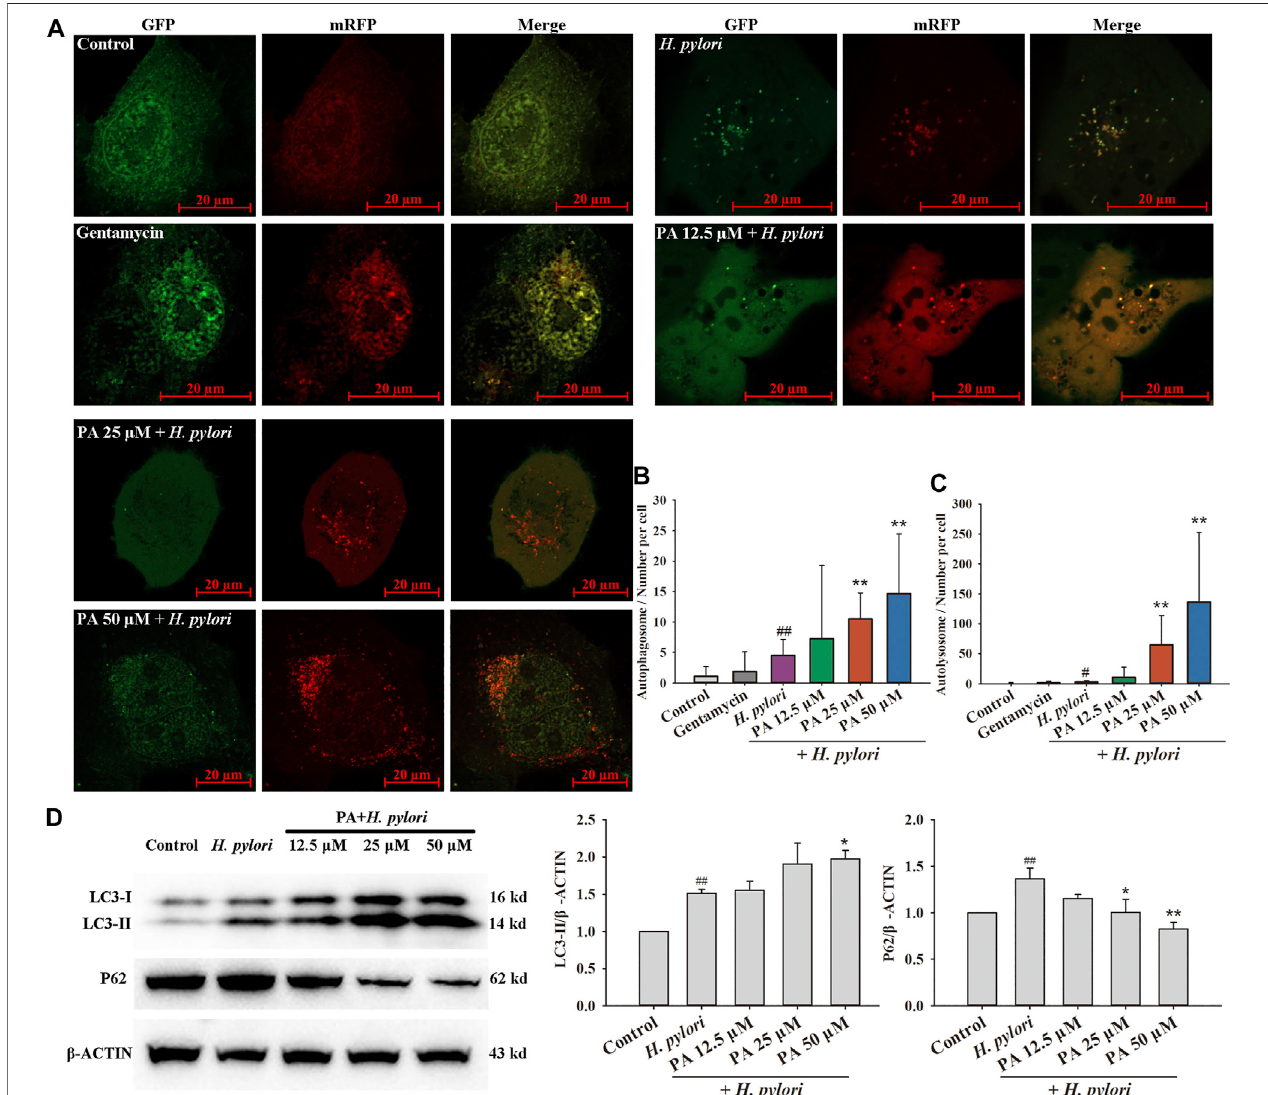
FIGURE 6 | Effects of PA on H. pylori -induced xenophagy. (A) Representative images of xenophagy after treatment with gentamycin and H. pylori with or without PA. (B) Quantitative results of autophagosomes ( n (cid:2) 4). (C) Quantitative results of autolysosomes ( n (cid:2) 4). (D) Representative Western blot results of LC3 and P62. UpregulationofLC3-IIcon fi rmedtheoccurrenceofxenophagy,whiledownregulationofP62revealedthefusionoflysosomeswithautophagosomesanddigestionofthe content ( n (cid:2) 5). The results indicate that PA improves the xenophagic fl ux and promotes digestion. ## p < 0.01, compared with the control group. * p < 0.05, ** p < 0.01, compared with the H. pylori